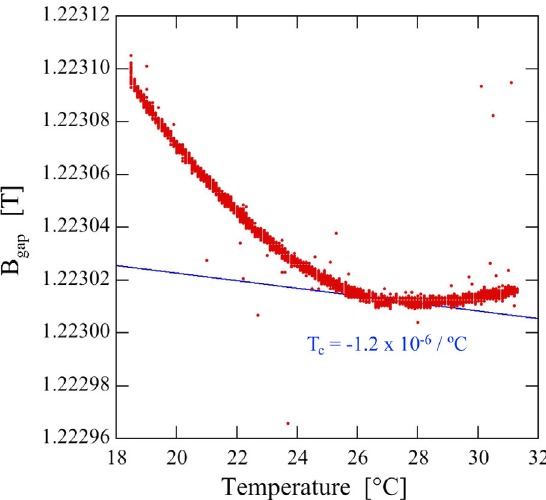
was obtained by fitting FIG. 13. Gap-field strength variation measured by moving the c lower and upper shunt